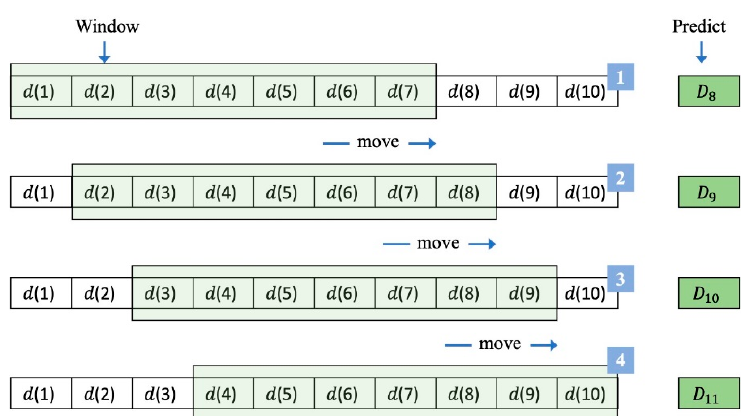
Figure 7. Sliding window of the α ‐ Sutte indicator.